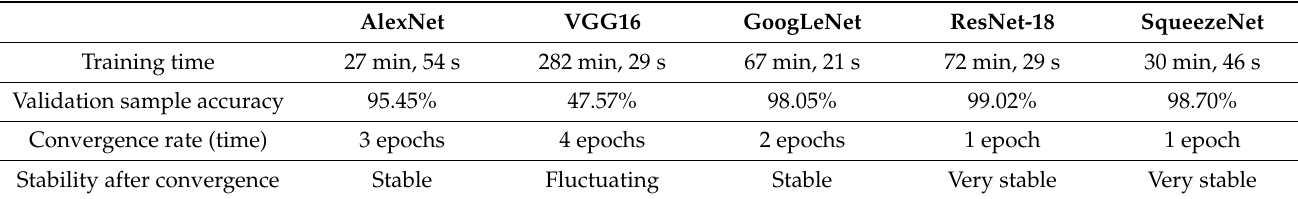
Table 1. Comparison of the training effects of the different network